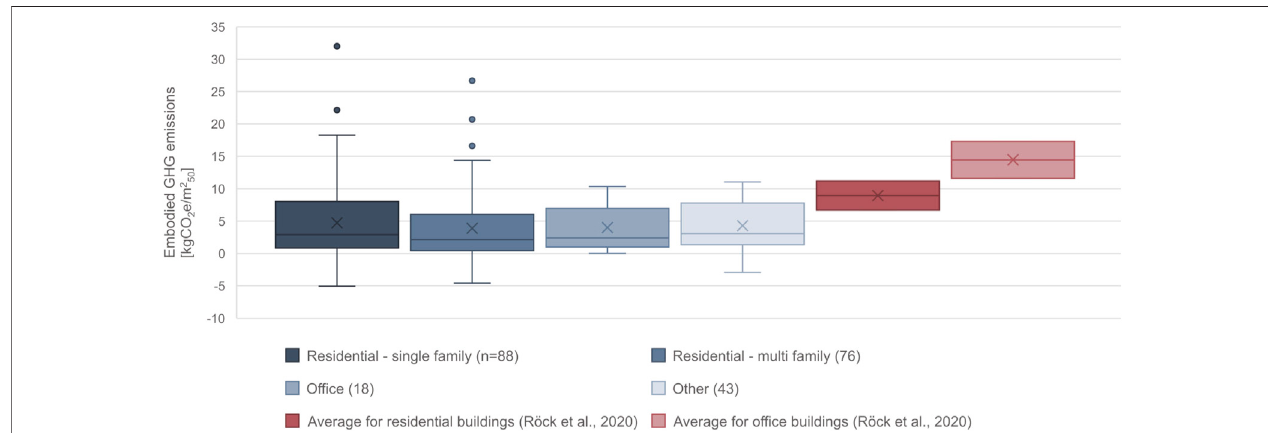
FIGURE 4 | Embodied GHG emissions distributed on building types and compared to the results from (Röck et al., 2020). The red boxes represent the average range inembodied GHGemissions forresidential and of fi ce buildings foundby(Röcket al.,2020).Thedotsintheplotindicate theoutliersofthedataset. Theboxesand the linewithin the boxes indicate the quartiles of the dataset (25 percentile, 50 percentile (median) and 75percentile). The x indicates the average. The error bars outside the boxes indicate the deviation in the data.